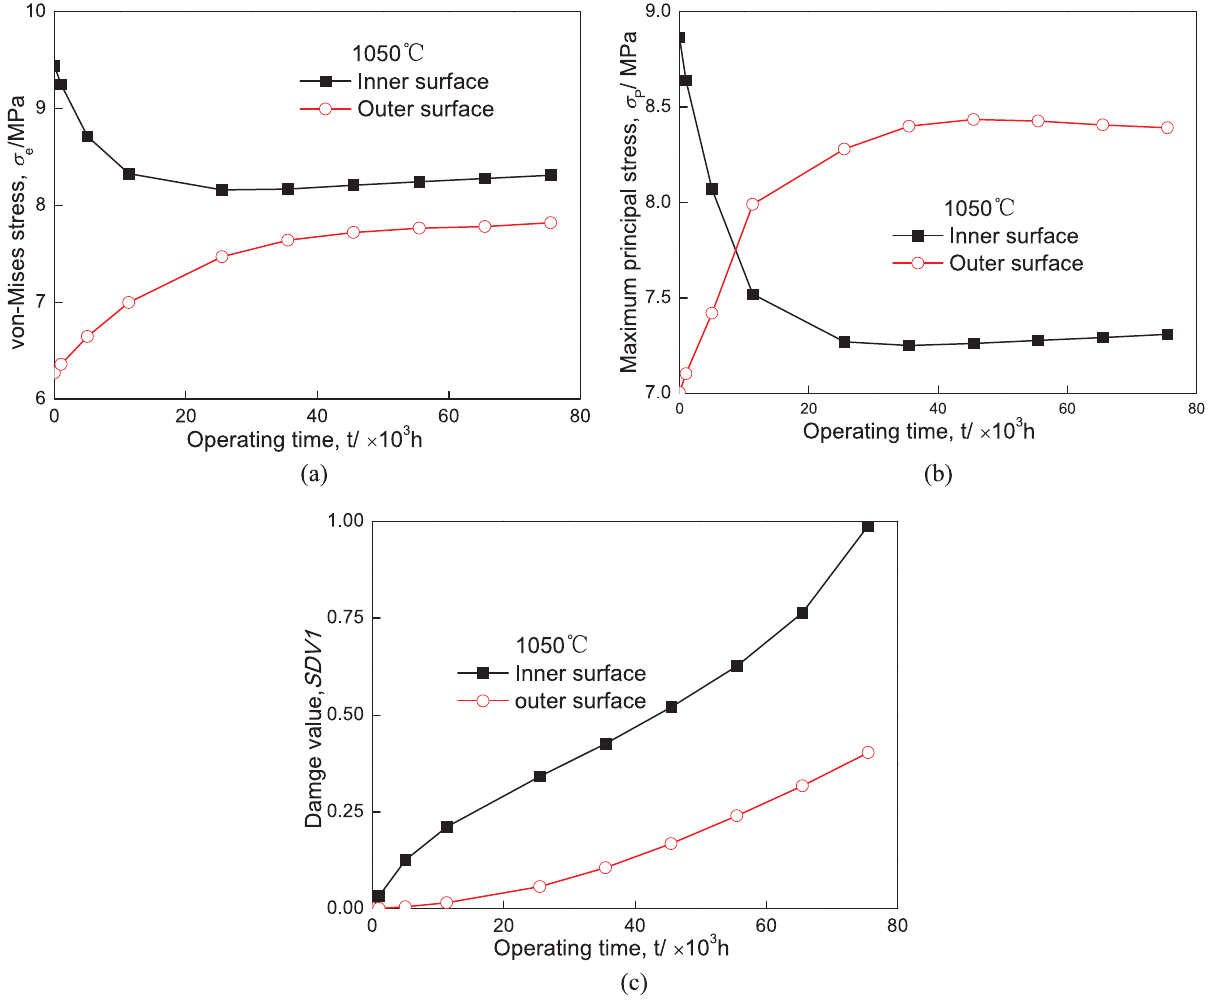
Fig. 6: The evolution of σ e , σ p and SDV1 along the inner surface and outer surface of Cr25Ni35Nb alloy tube during the service life at 1050 °C: